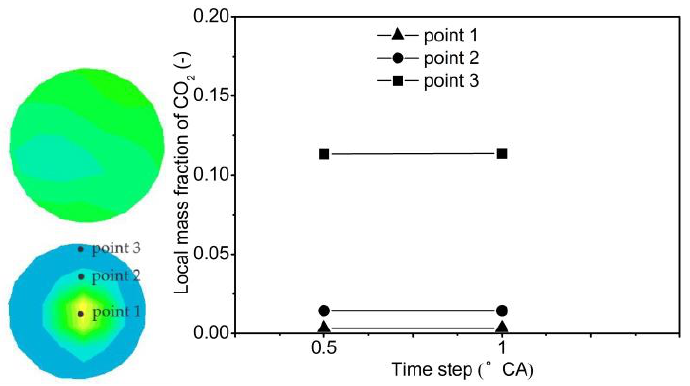
Figure 5. Independent validation of the transient time step with the local mass fraction of CO 2 at the outlet of intake port 1.